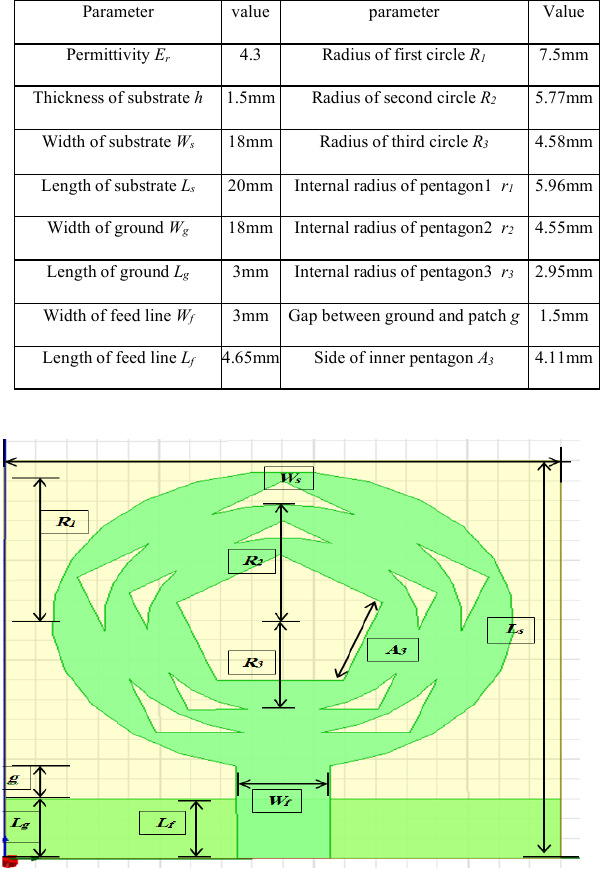
Figure 4 Geometrical view of projected fractal MSA